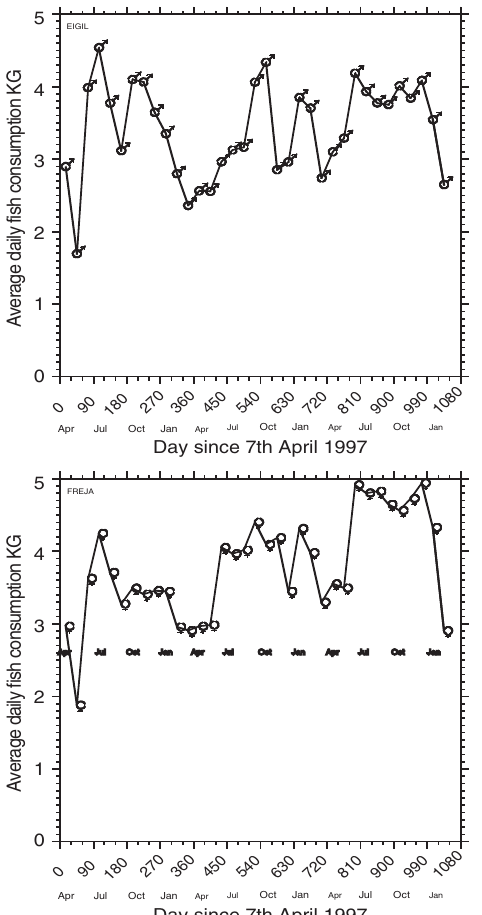
Fig.9. Average daily food consumption by month for Eigil and Freja since 7th April